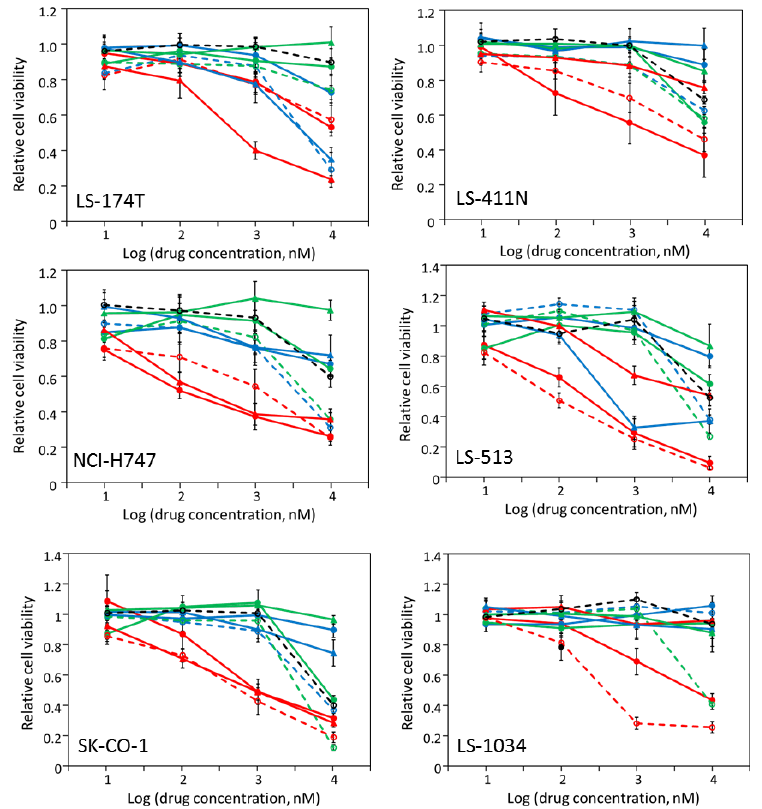
Figure 2. Drug sensitivity of seven colorectal cancer cell lines. The assay and data processing are identical to that of Figure